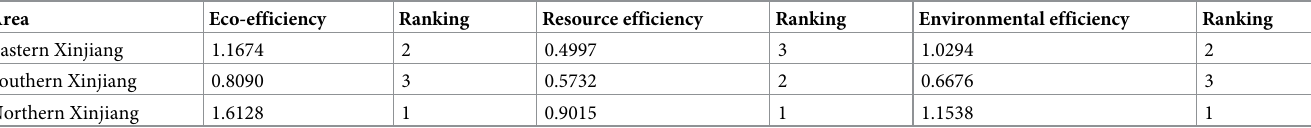
Table 2. Ecological efficiency and deconstruction analysis of different regions from 2001 to 2015.